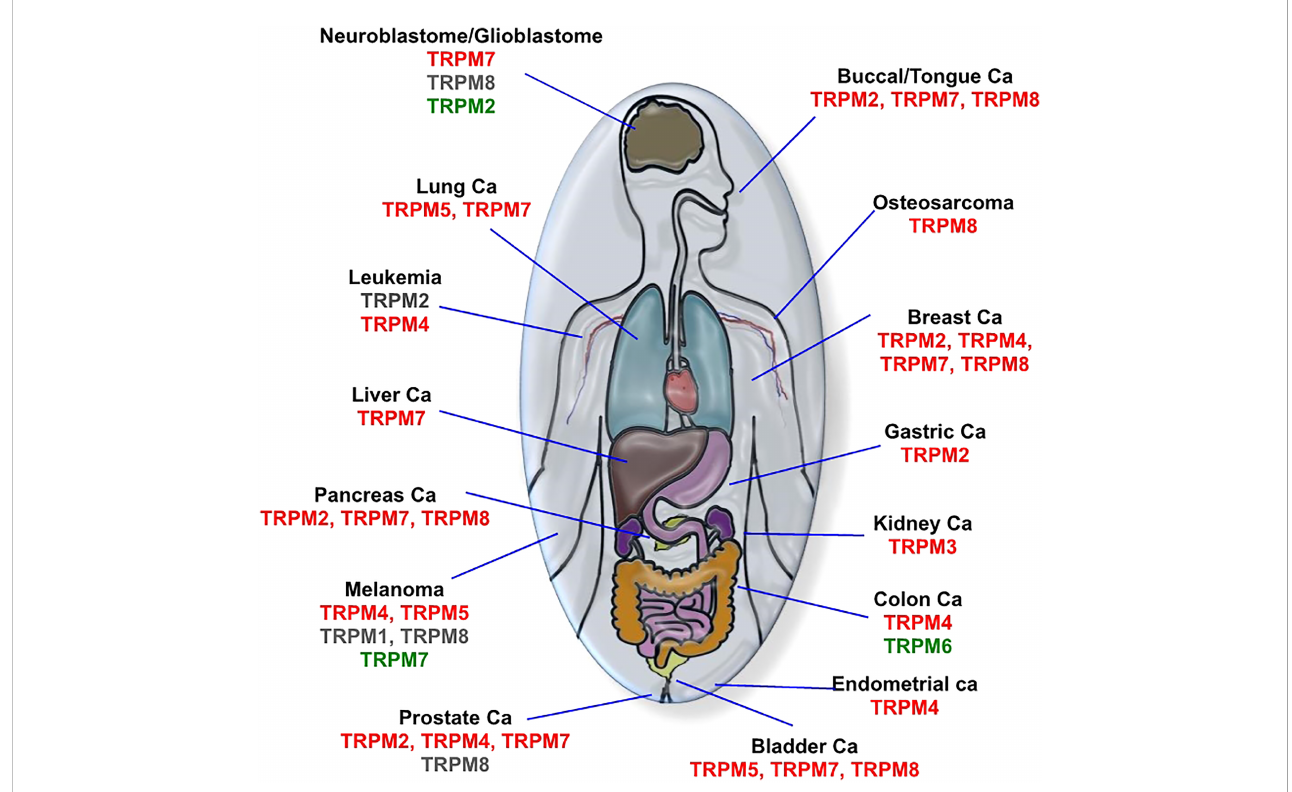
FIGURE 2 Relation between cancer types and TRPM channel expression. Overexpressed channels with the potential bene fi cial role of antagonists are indicated in red; down-regulated channels with a possible bene fi cial effect of agonists are in green; the controversial role of channel according to similar bene fi ts of agonists and antagonists are in